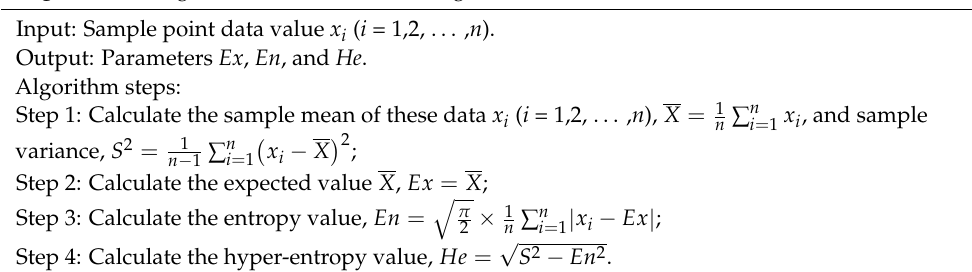
Algorithm 2. Algorithm of backward cloud generator